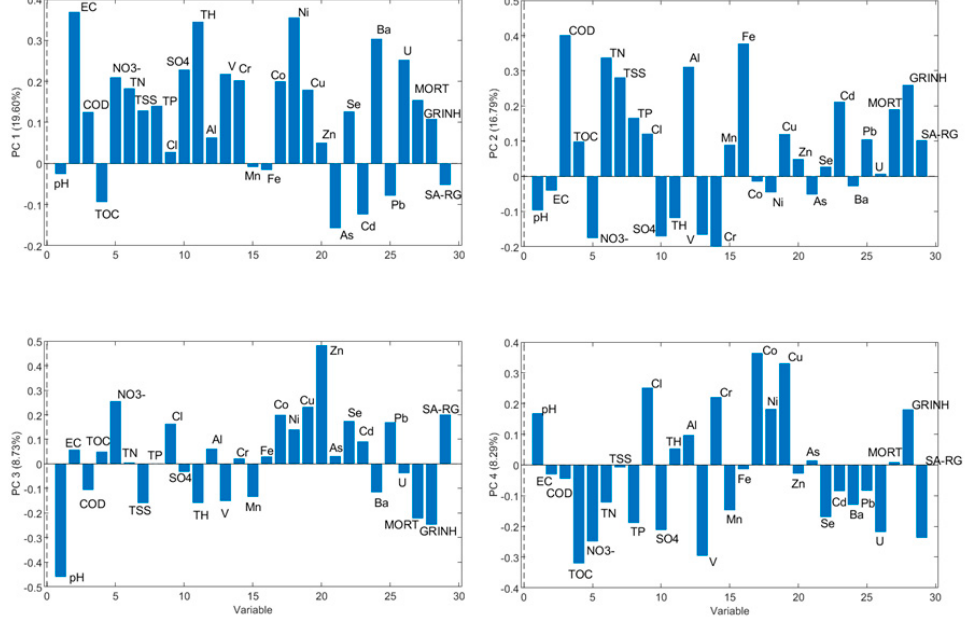
Figure 3. Factor loadings plot for four latent